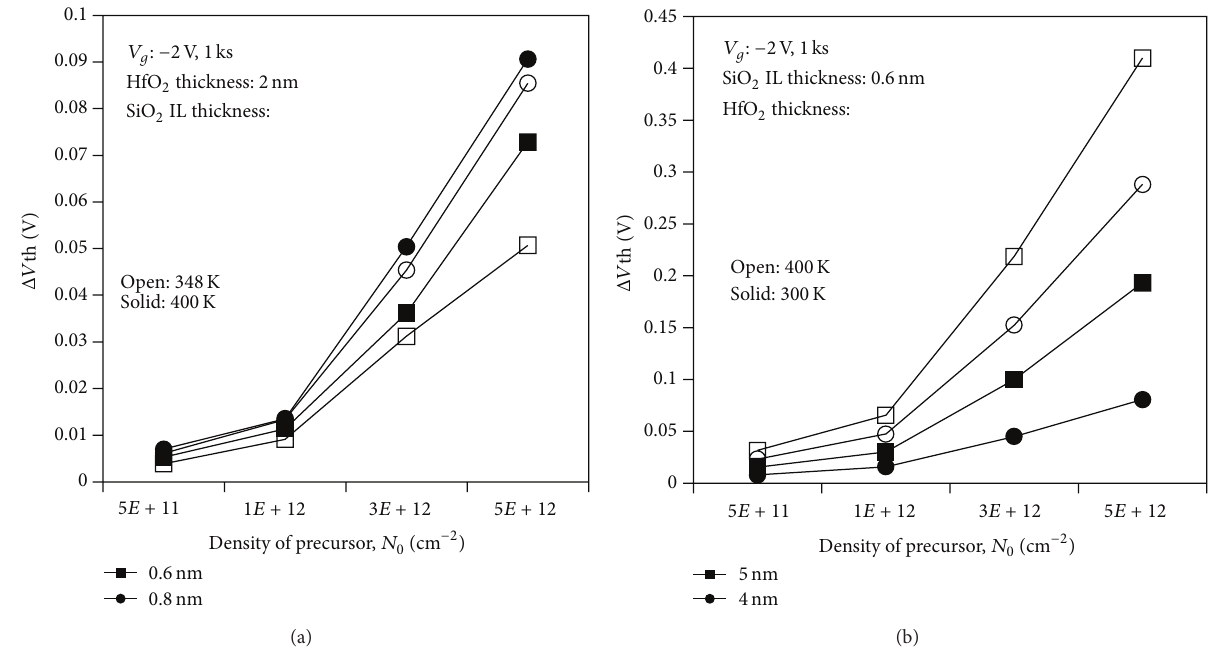
Figure 9: Evolution of threshold voltage shift based on different densities of precursor. (a) Variation in thicknesses of SiO 2 with thickness of 2 nm HfO 2 . (b) Variation in thicknesses of HfO 2 with thickness of 0.6nm SiO 2 interface layer.